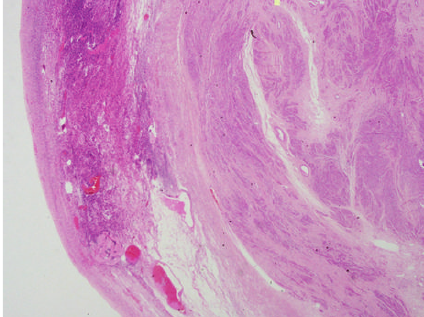
Figure 4: Low microscopic view shows diffuse strong positivity of the ovarian leiomyoma cells for desmin marker confirming smooth cell origin (immunohistochemistry stain).